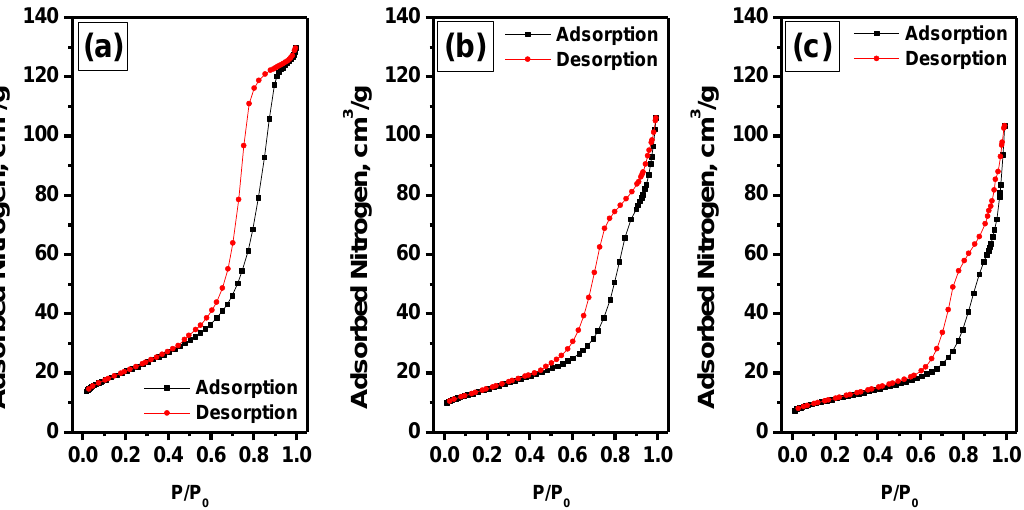
Figure 1. Low-temperature nitrogen adsorption/desorption isotherms for C12A7 ( a ); 5%V/C12A7 ( b ); and 10%V/C12A7 ( c ) samples.